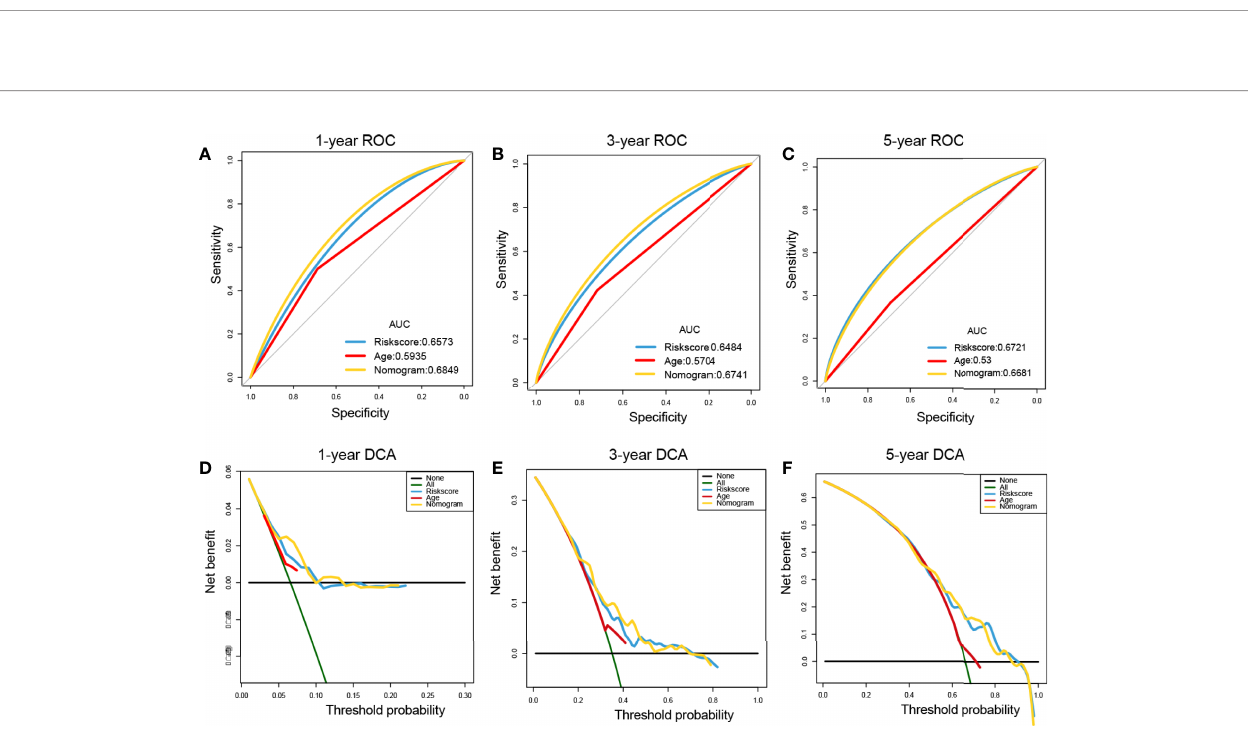
FIGURE 8 | Prognostic predictive assession of risk score and clinical pathological features for patients with OC. (A, B) Univariate and multivariate cox analysis of clinical variables and clinical pathological features; (C) nomogram between clinical features and risk score; (D) calibration chart of the nomogram at 1, 3, and 5 years. P < 0.05 was considered as signi fi cant. *P < 0.05, ***P < 0.001.